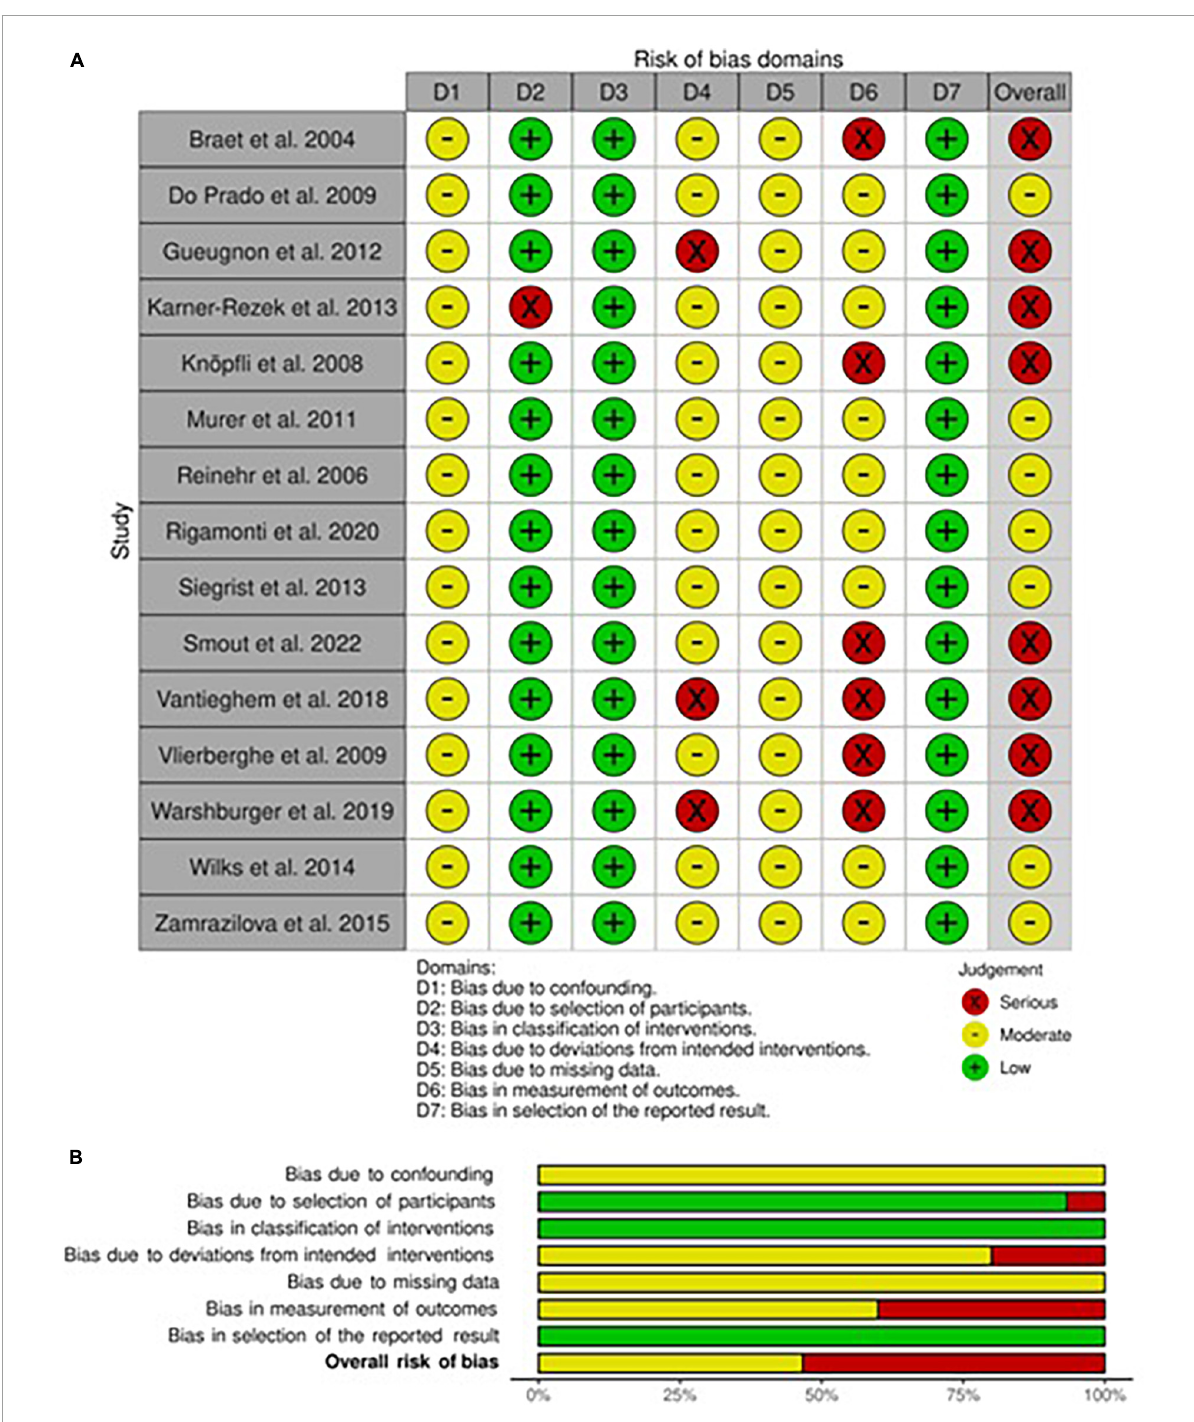
FIGURE3 Risk of bias within longitudinal studies in children and adolescents. (A) Traffic light plot and (B) summary plot presenting the risk of bias within the longitudinal studies included in the systematic review.